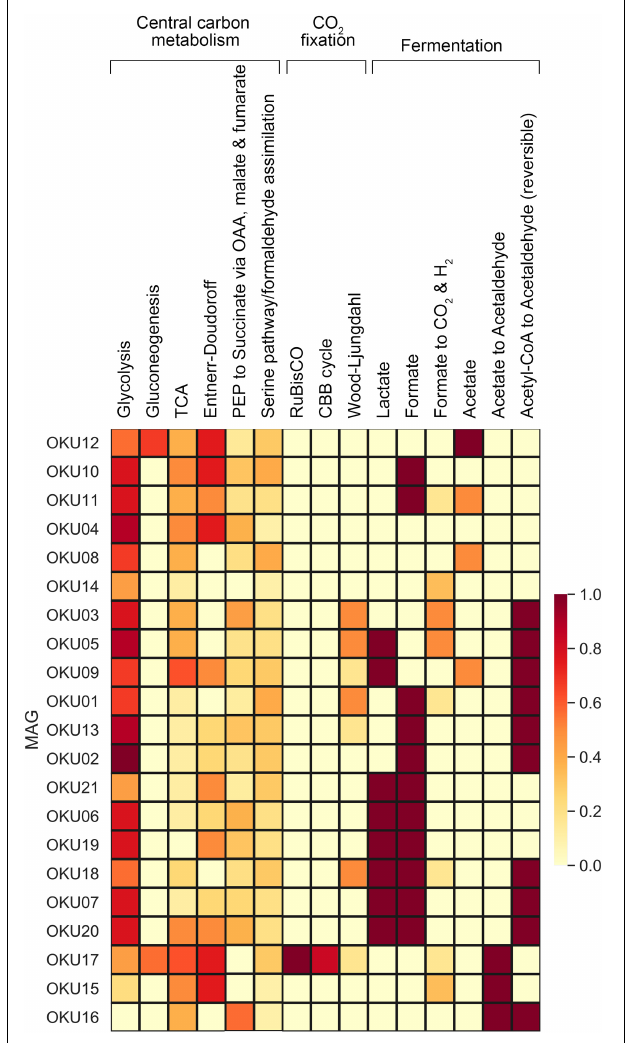
FIGURE 9 | Central carbon metabolism, carbon fixation pathways, and mixed acid cycle completeness estimated with Keggdecoder. Dark red color indicates full pathway, orange partially detected pathways, and light-yellow color indicates a missing pathway.